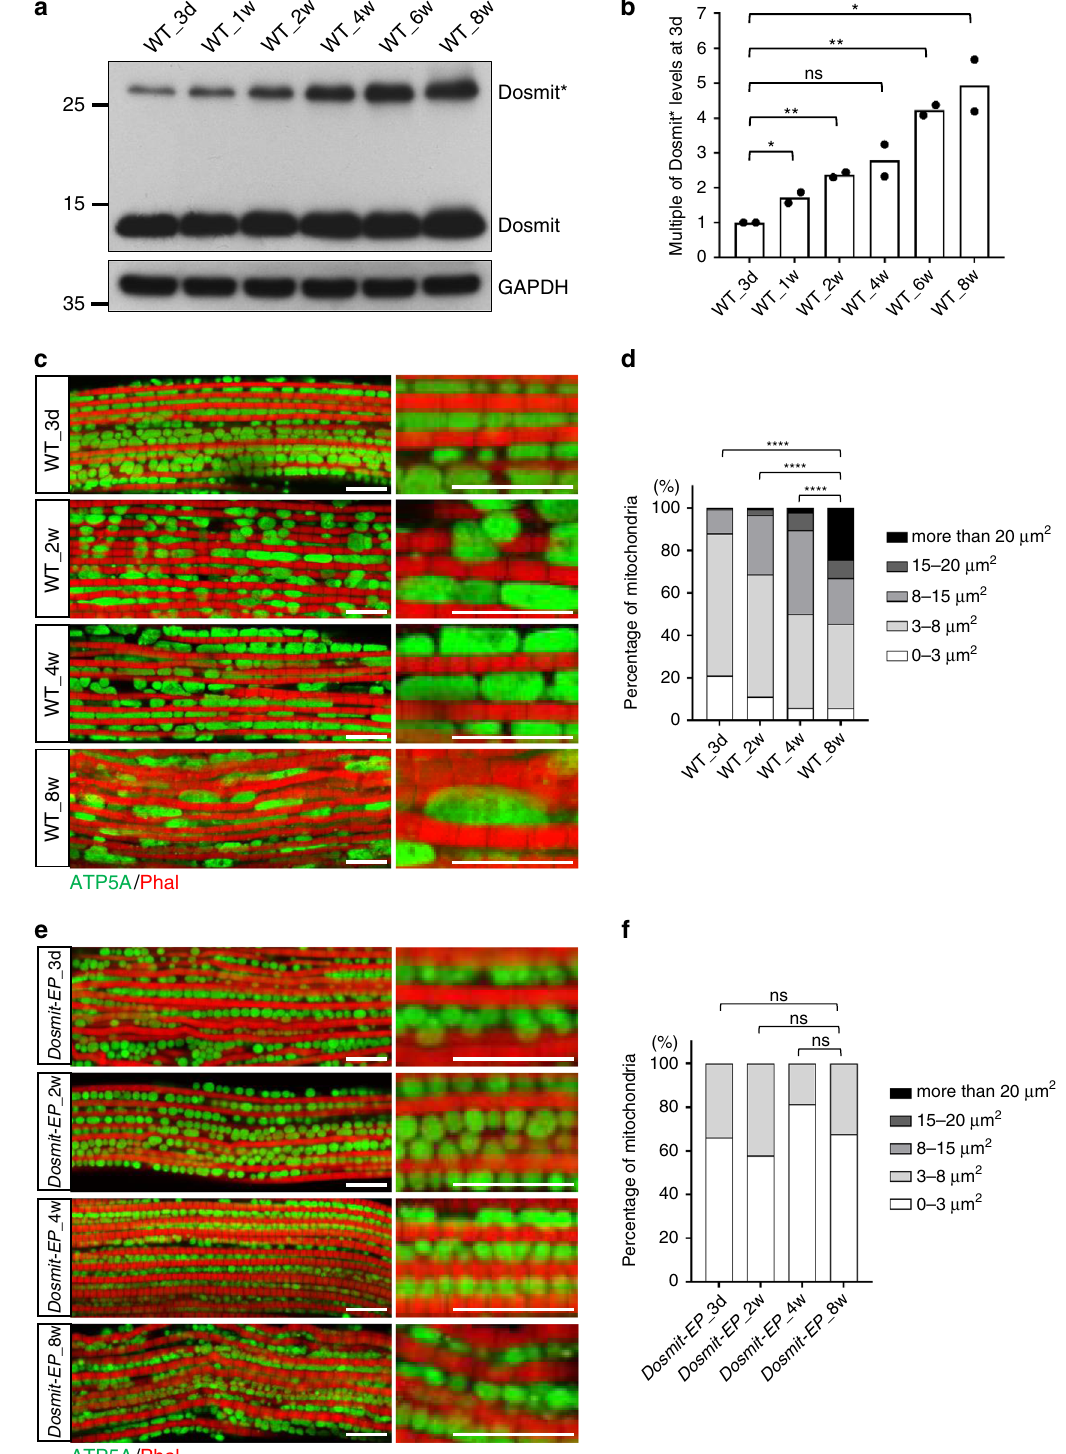
Fig. 3 Dosmit protein expression levels increase in wild-type fl ies throughout natural aging. a Western blot of Dosmit in fl ight-muscle tissue homogenates from wild-type fl ies aged 3 days, 1 week, 2 weeks, 4 weeks, 6 weeks, or 8 weeks. Dosmit* represents dimerized Dosmit. GAPDH: loading control. b Dosmit* expression levels based on the western blot of each age group. N = 2. Statistical test: two-tailed student ’ s t- test (** p < 0.01; * p < 0.05; ns: p = 0.0604). c Immuno fl uorescent staining showing mitochondria of wild-type fl ies aged 3 days, 2 weeks, 4 weeks, or 8 weeks. Scale bar: 10 μ m. d Relative abundance of mitochondria of different sizes for each wild-type fl y age group. N = 133, 144, 86, and 106 from left to right bars. Statistical test: Chi-Square test (**** p < 0.0001). e Immuno fl uorescent staining showing mitochondria of Dosmit-EP fl ies aged 3 days, 2 weeks, 4 weeks, or 8 weeks.